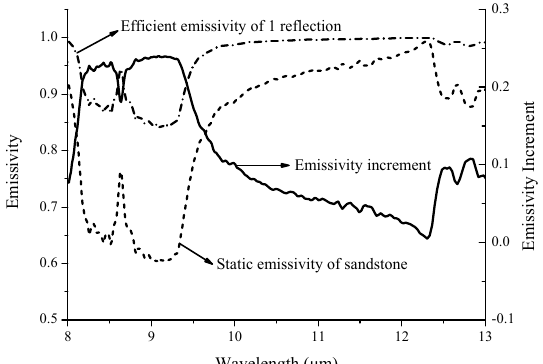
Figure 8. Simulation of the effective emissivity spectra caused by the cavity effect for quartz sand- stone.